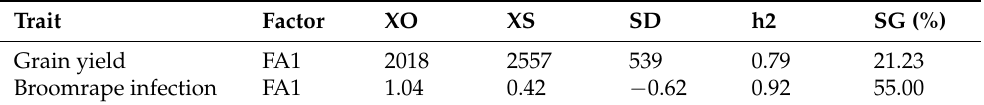
Table 6. Estimates of the original mean (XO); mean of the selected accessions (XS); selection differen- tial (SD); the broad heritability (h2) and selection genetic gains (SG%), based on MTSI for the 15 faba bean accessions tested in six